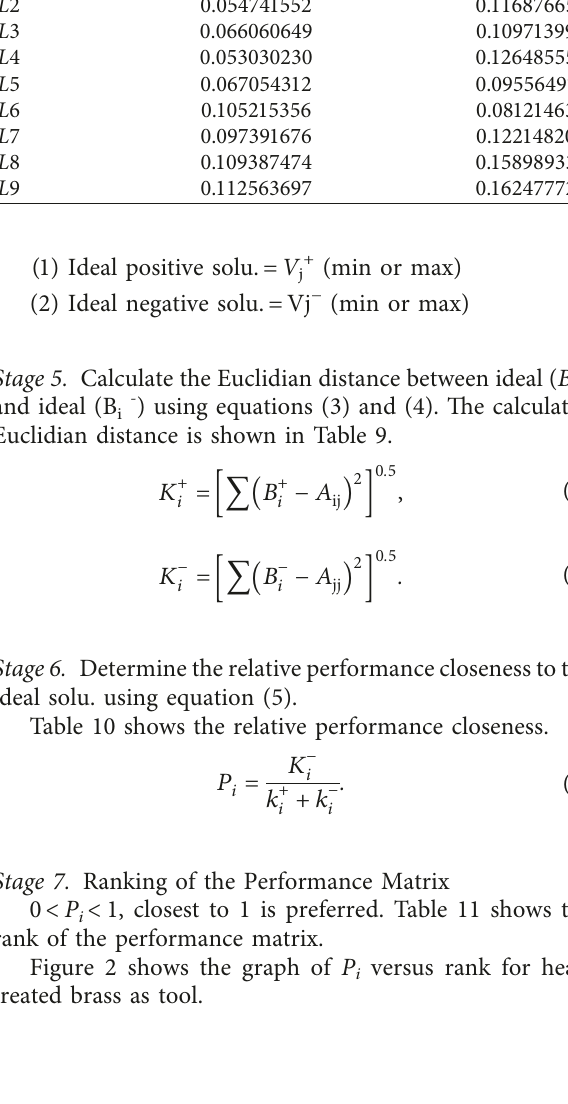
Table 9: Euclidian distance between ideal ( B + Exp.